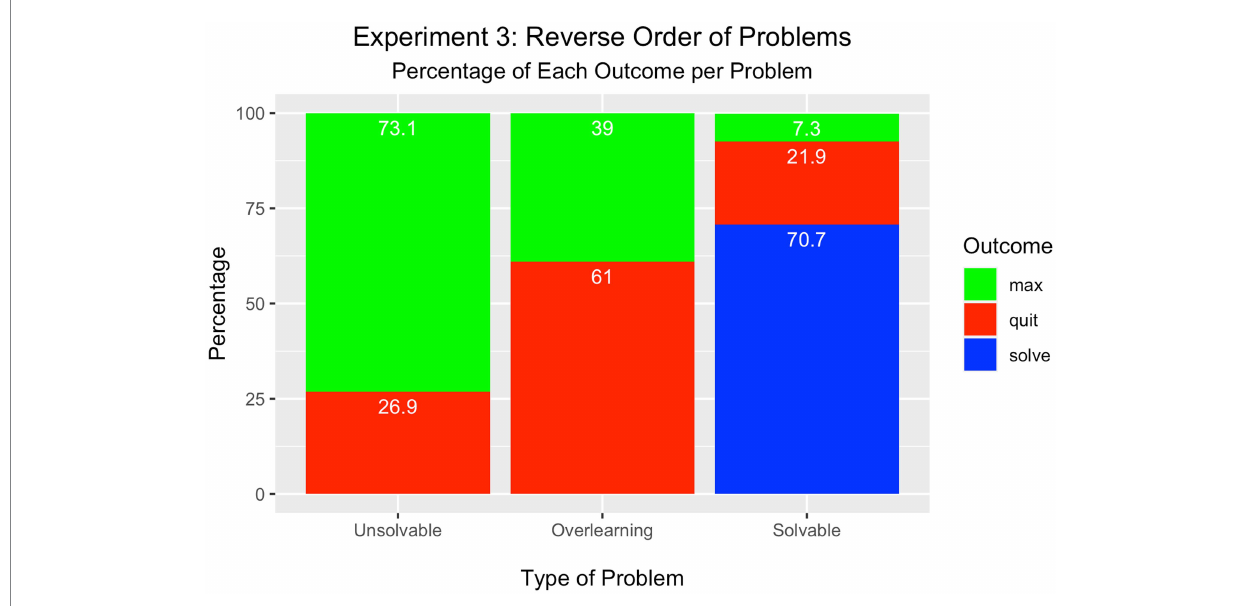
FIGURE 4 Experiment 3 – Reverse Order